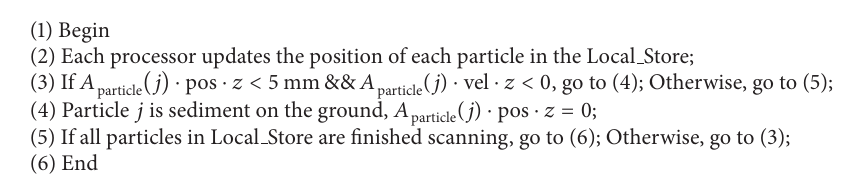
Algorithm 2: The sediment simulation algorithm of dust particles.